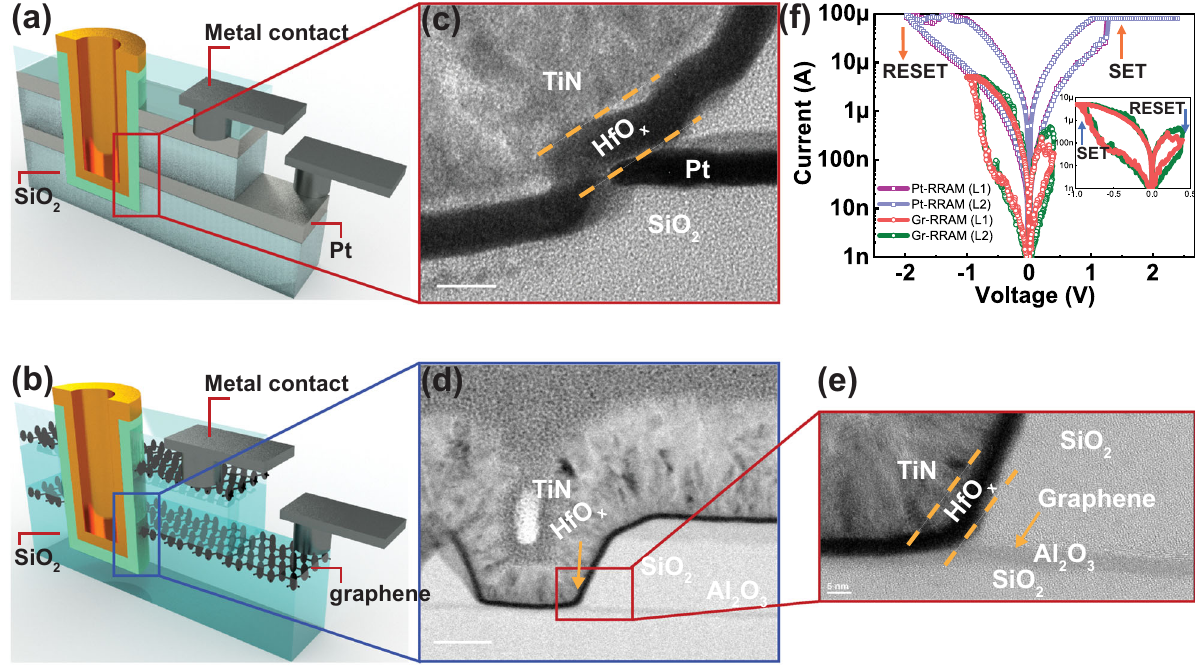
Fig. 1 3D VRRAM single device structure. a, b Single device cross-sectional schematic for a Pt and b graphene plane electrode-based VRRAM with two layers. In this work, TiN/HfO x /graphene and TiN/HfO x /Pt 3D VRRAM structure can be further referred to as Gr-RRAM and Pt-RRAM, respectively. c High-resolution TEM image of Pt-RRAM device from previous work 34 (Scale bar: 5 nm). d High-resolution TEM image of Gr-RRAM device (Scale bar: 30 nm). e Layer 1 example image, where graphene was transferred on top of the Al 2 O 3 layer serving as an adhesion promoter. (Scale bar: 5 nm). f Typical semilogarithmic I – V curve of the top and bottom layers for both Pt- and Gr-RRAM